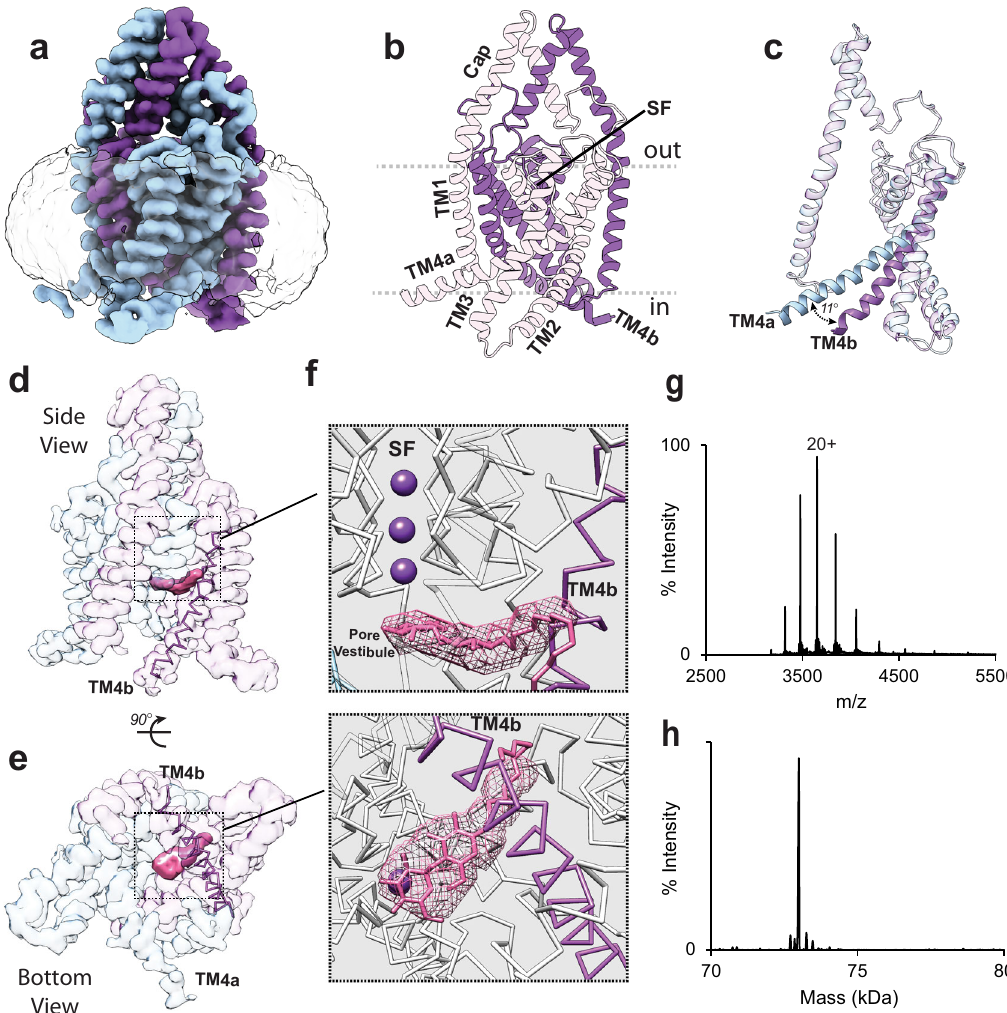
Fig. 1 | Subunit asymmetry in the TREK1 apo cryo-EM structure. a Cryo-EM density map of the apo state of the TREK1 channel and b a structural model of the channel,withthepotassiumionselectivity fi lter(SF),extracellularcapdomain,and four transmembrane domains labeled. c A superposition of the two apo TREK1 subunits, showing asymmetric positioning of TM4a (blue) relative to TM4b (purple), due to an 11° tilt in the distal portion of TM4. Transparent views of the TREK1cryo-EMdensitymap d sideviewand e bottomview,withdensityoutsideof